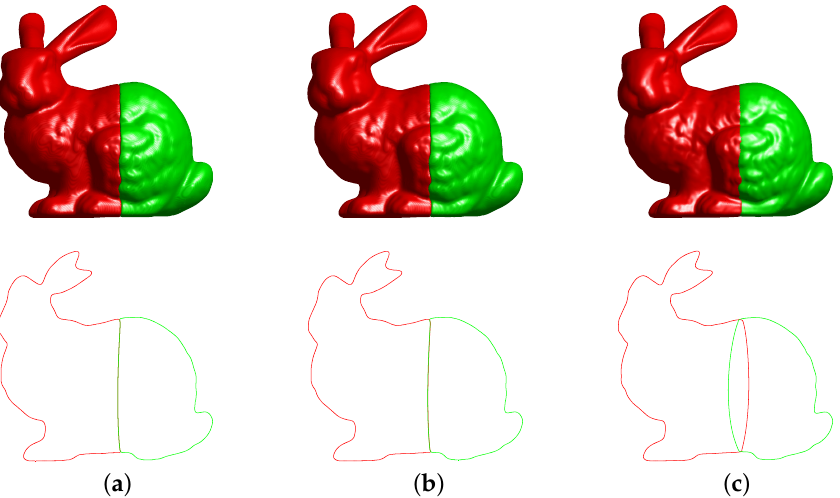
Figure 9. Illustration for the parameter λ sensitivity analysis. ( a ) λ = 0.01. ( b ) λ = 0.1. ( c ) λ = 10.